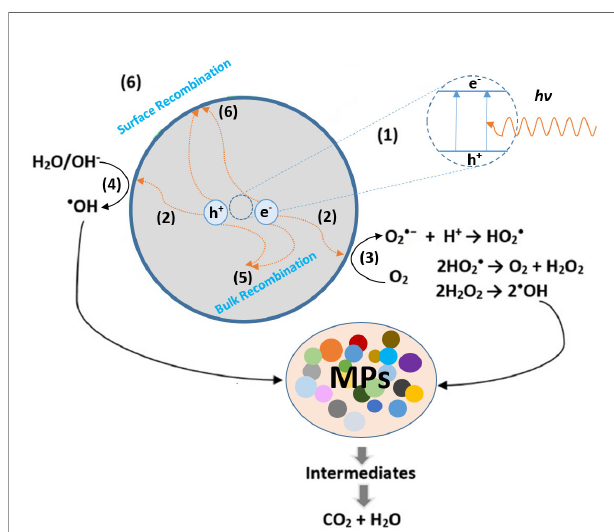
FIGURE 3 | Photocatalytic degradation steps of microplastics at the surface of the semiconductor under light irradiation: (1) (e − ) – (h+) seperation, (2) Diffusion of the charge carriers on the surface of the photocatalyst, (3),(4) light-driven catalytic oxidation and reduction takes place on the active sites of the catalyst, (5) (e − ) – (h + ) recombination inside the catalyst, (6) (e − ) – (h + ) recombination at the catalyst